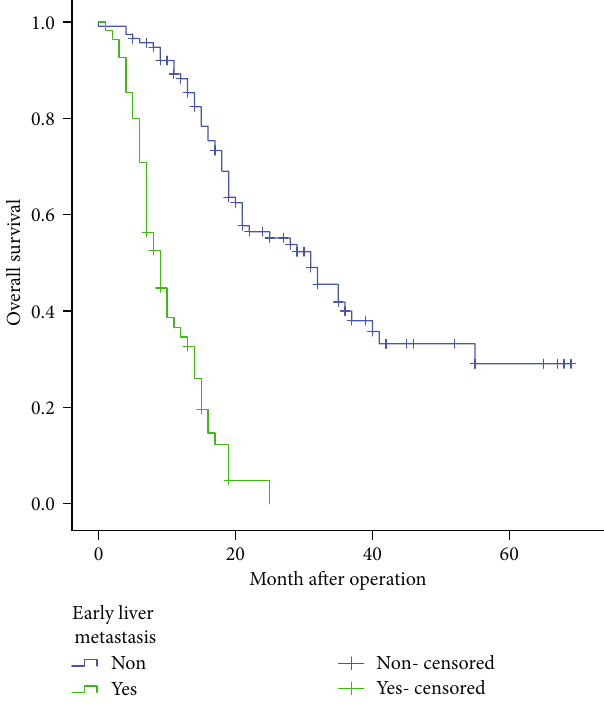
Figure 2: Overall survival curve for patients with early liver